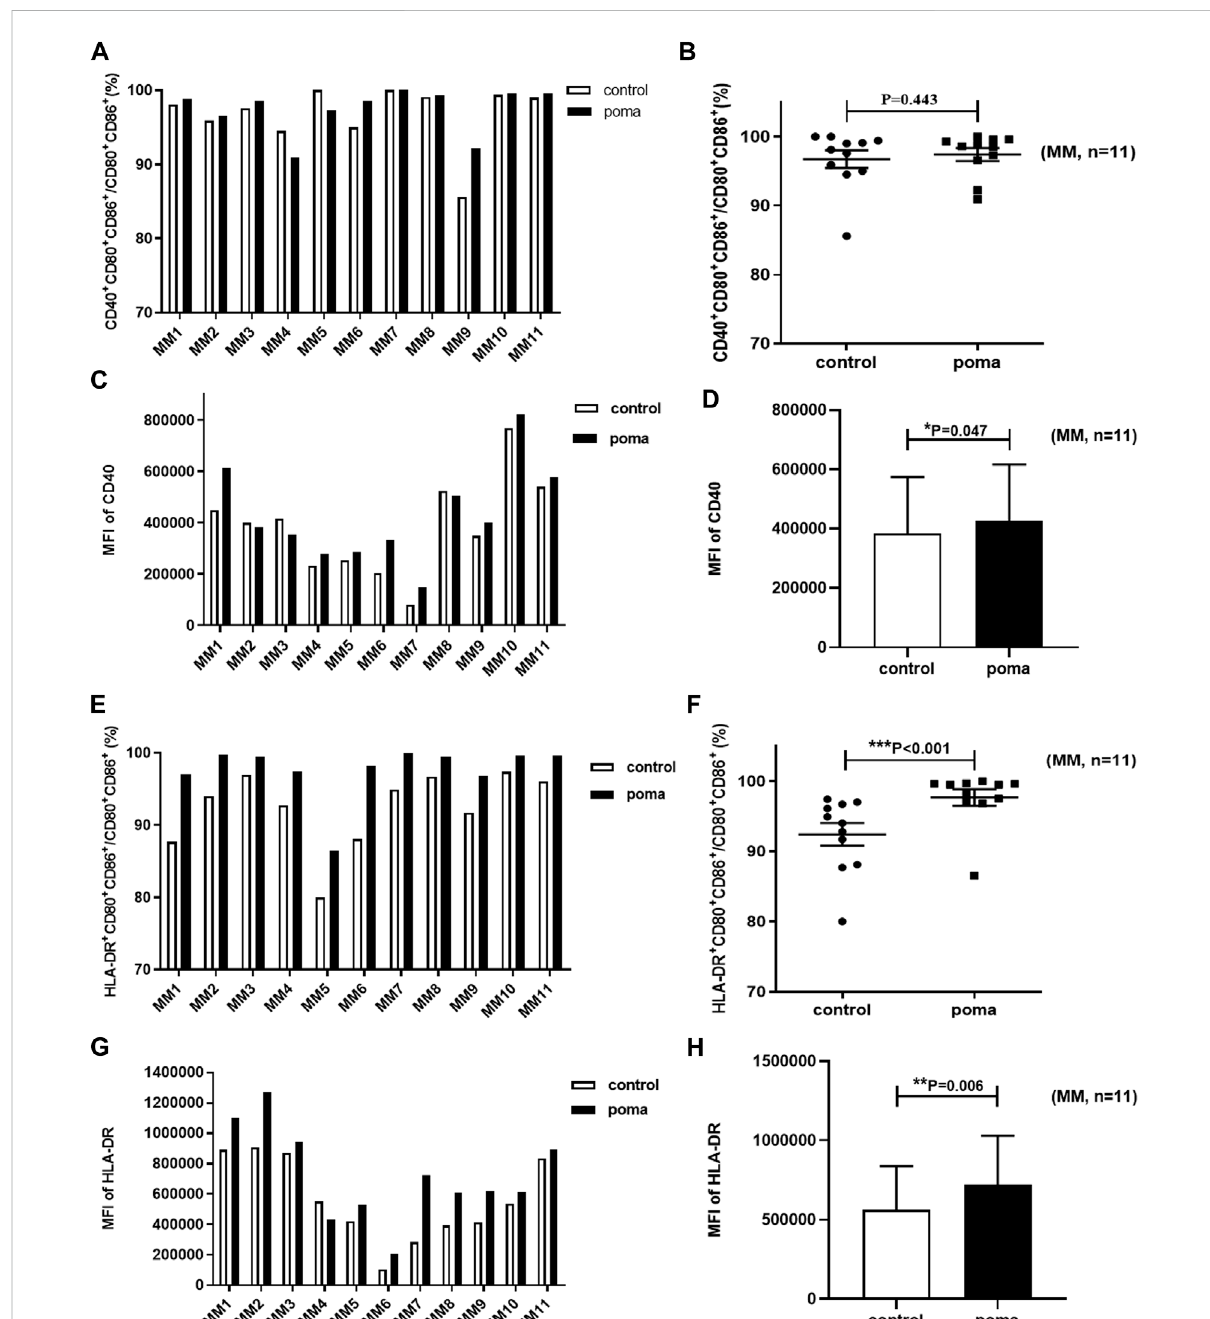
The effect ofpomalidomide on the expression ofmaturation-related surface markers of MM patient-moDCs ( n = 11). The proportion of CD40 + moDCs in total moDCs was shown in (A,B) while the MFI of CD40 expression on moDCs was shown in (C,D) . The proportion of HLA-DR + moDCs in total moDCs was shown in (E,F) while the MFI of HLA-DR expression on moDCs was shown in (G,H)